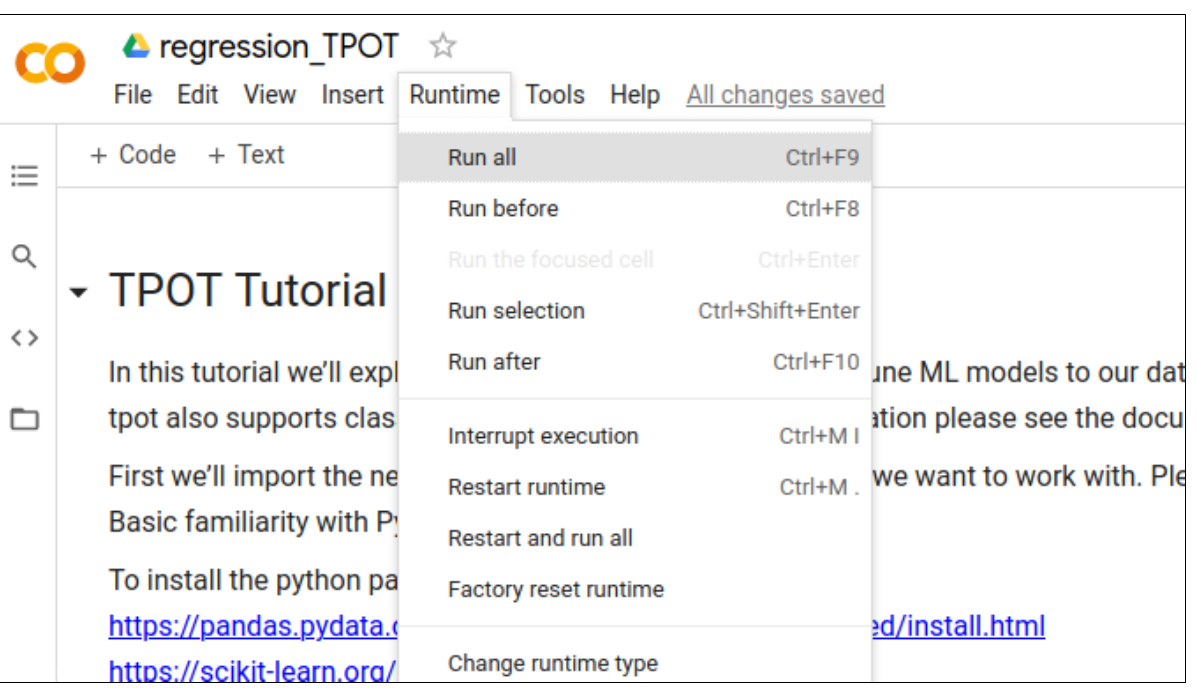
Figure A-7. Run All